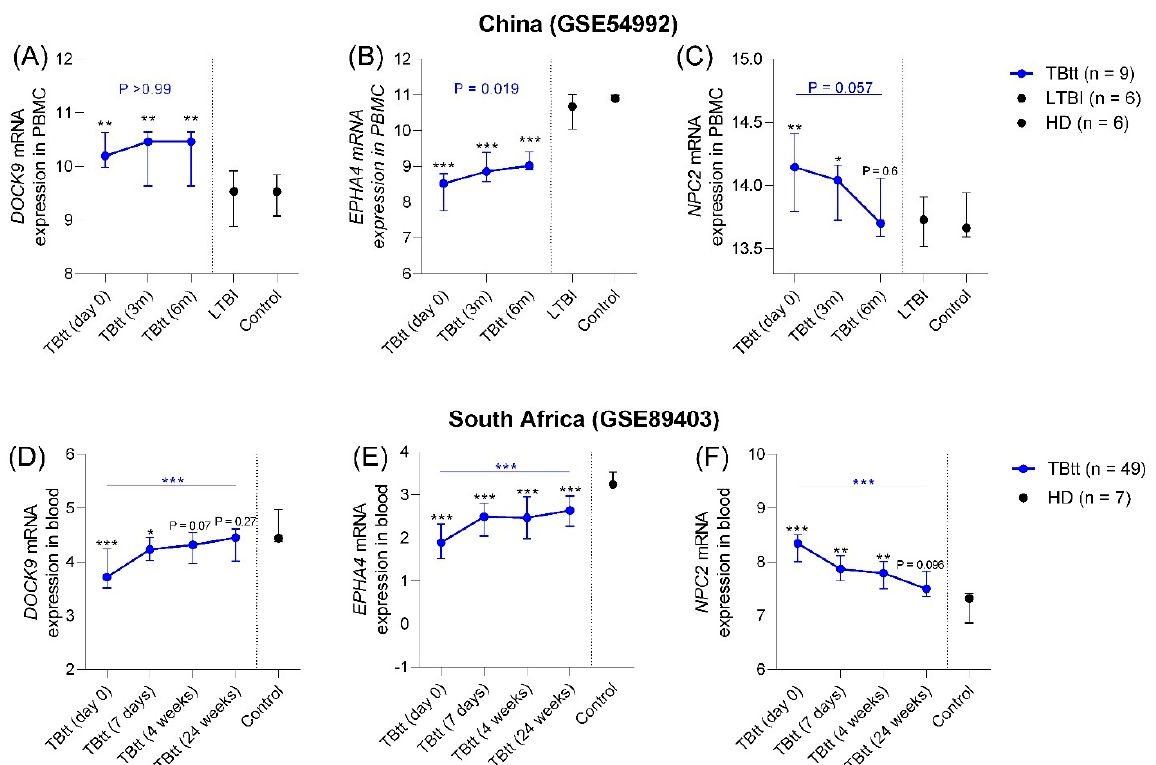
Figure 5. Effects of anti-tuberculosis chemotherapy on the expression of DOCK9 , EPHA4, and NPC2 mRNAs in blood samples from TB patients. Transcriptomic data were obtained from two publicly available datasets, China (GSE54992, A – C ) and South Africa (GSE89403, D – F ). Follow-up samples from TB-treated (TBtt) patients were collected before treatment initiation (day 0), at different time intervals during therapy (GSE54992: 3 months [m]; GSE89403: 7 days, and 1 month), and at the end of therapy (GSE54992: and GSE89403: 6 months). The Friedman test was used to assess significance of the longitudinal analysis among TB cases during treatment. The Mann–Whitney test was used to assess significance between two groups vs. LTBI or vs. control. The Kruskal–Wallis test was used to assess significance of global differences across more than two groups, followed by Dunn’s multiple comparison tests correction. p -values obtained comparing TBtt time intervals against non-TB cases (LTBI and control) are shown in black ( • ). p -values obtained comparing expression changes in TBtt patients during treatment are shown in blue ( • ). * p -value < 0.05; ** p -value < 0.01; *** p -value < 0.005.